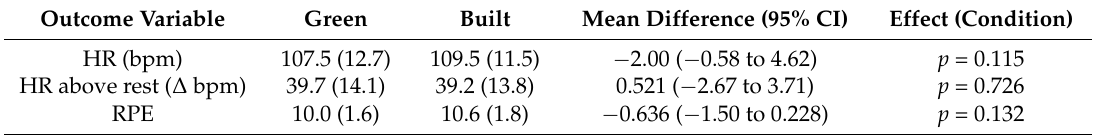
Table 2. Differences in heart rate and perceived exertion during exercise following green or built walks. Outcome